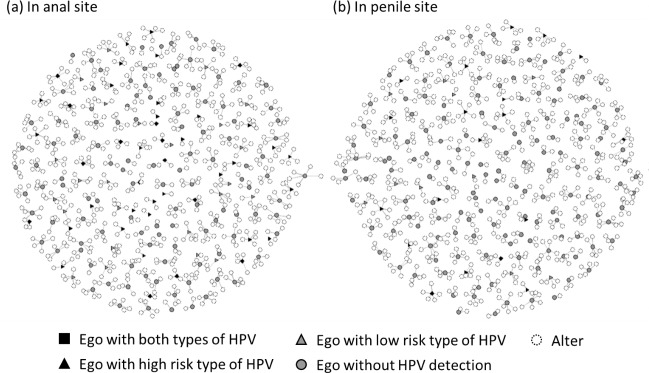
HPV detection denoted on the network graph.